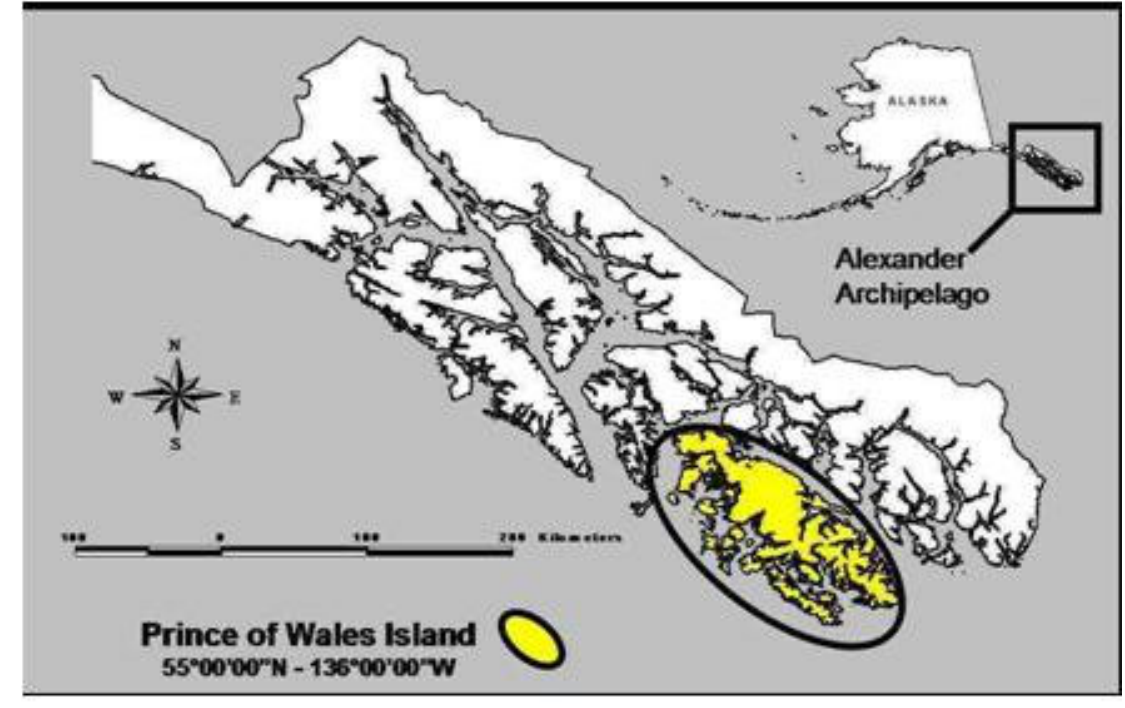
Fig. 1 . Location of the Alexander Archipelago and Prince of Wales Island in southeast